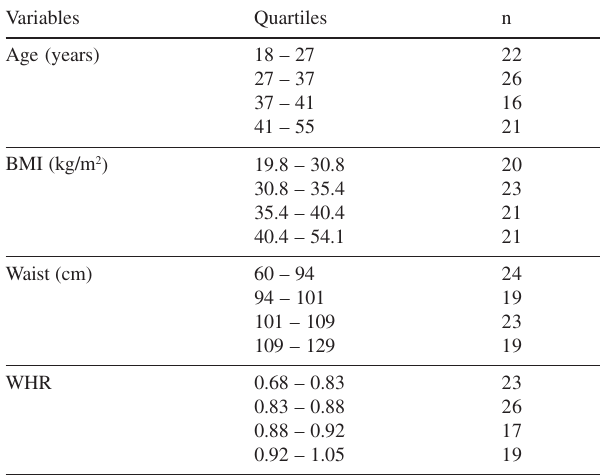
Table 1- General characteristics of the sample of the 85 subjects investigated